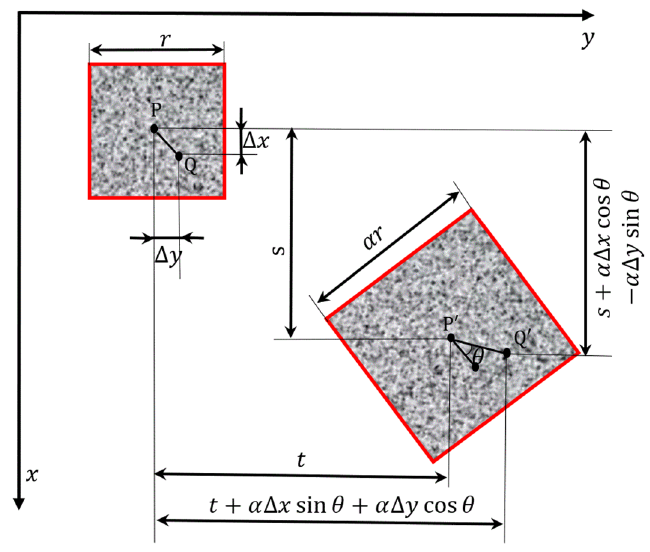
Figure 1. Sub-region before and after rigid body rotation and scaling.